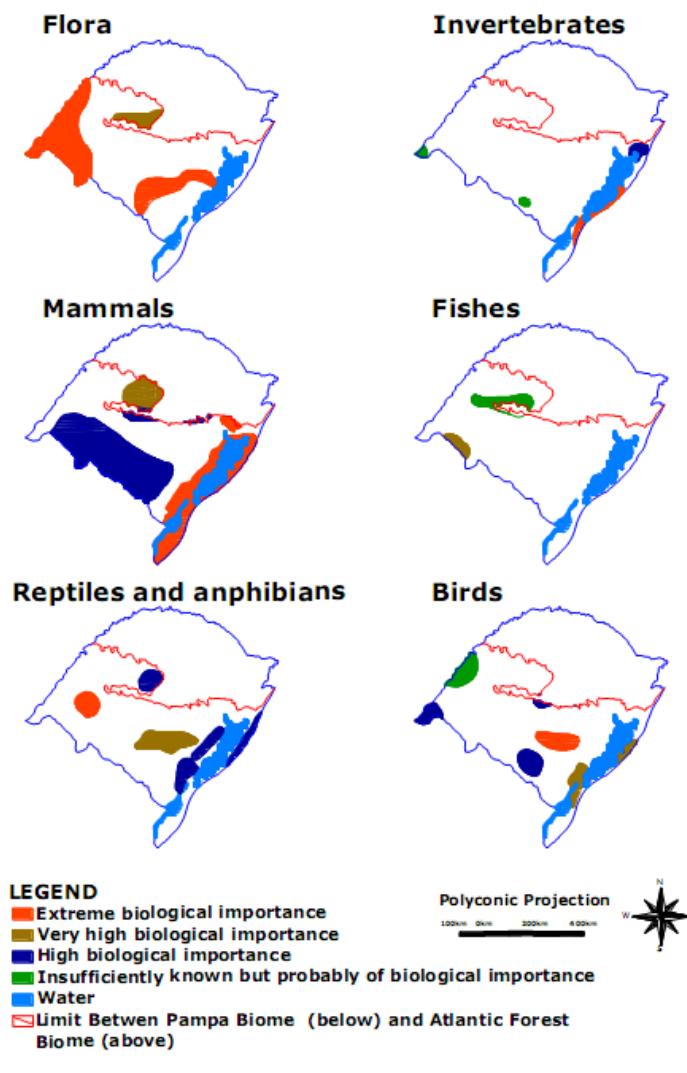
Figure 5. Areas of importance for conservation of the flora and fauna biodiversity in the Pampa biome. Adapted from MMA